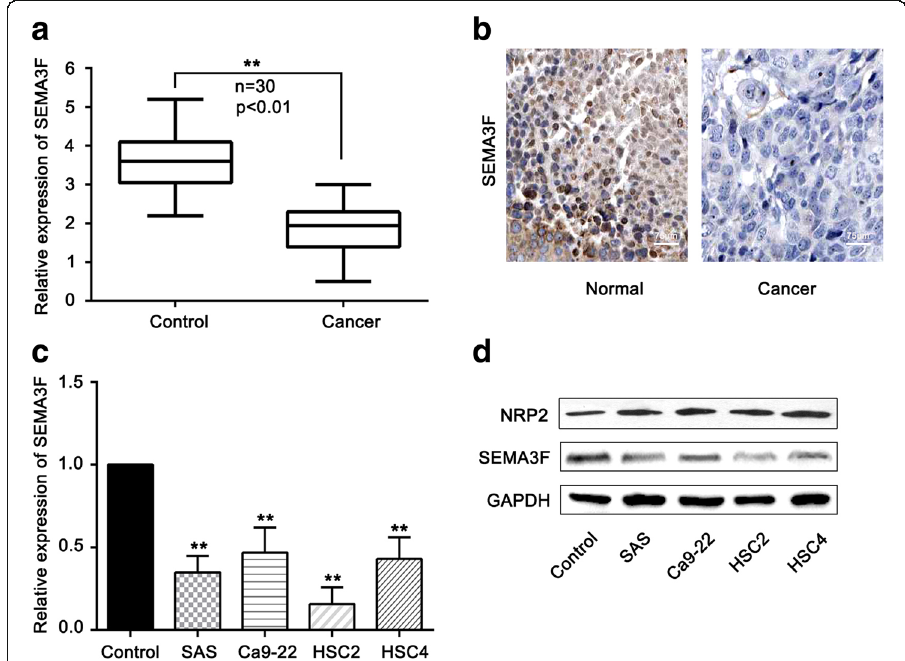
Fig. 1 Expression of SEMA3F in oral cancer tissue samples and cells. a – qRT-PCR analysis of the expression of SEMA3F in 30 OSCC tissues and adjacent normal tissues. b – The expression of SEMA3F was tested in OSCC tissues and adjacent normal tissues using IHC. Scale bar is 75 μ m. c – qRT-PCR analysis of the expression of SEMA3F in 4 OSCC-derived cell lines and one normal cell line. d – Western blotting showing the protein levels of NRP2 and SEMA3F in 4 OSCC-derived cell lines and one normal cell line. ** p <0.01 as compared with the control. The experiments were run three